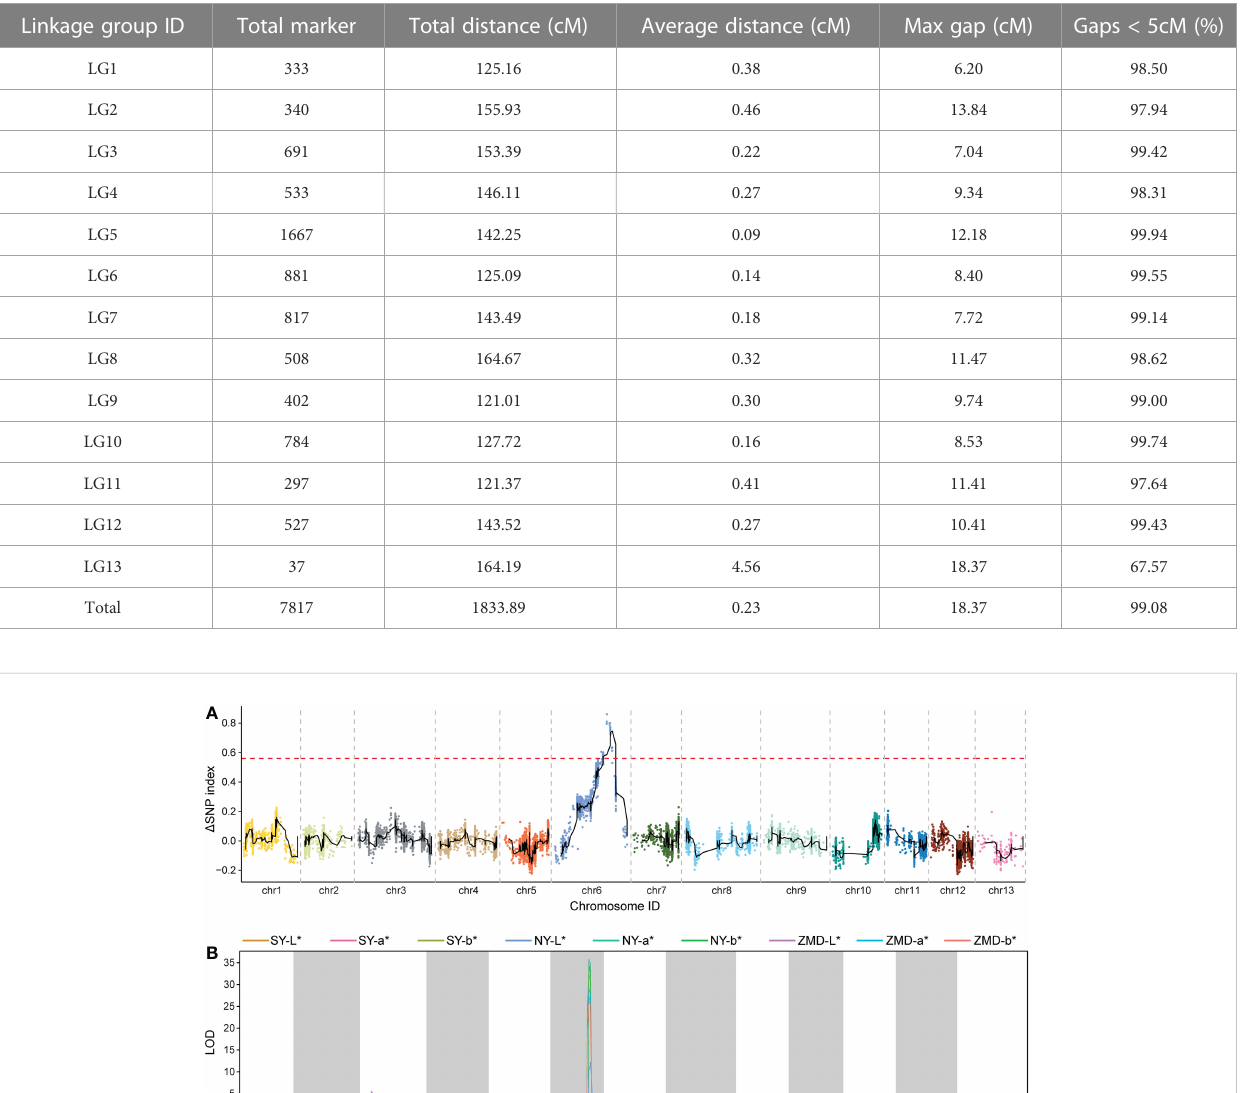
TABLE 2 Basic information of the high-density genetic linkage map of RIL population. Linkage group ID